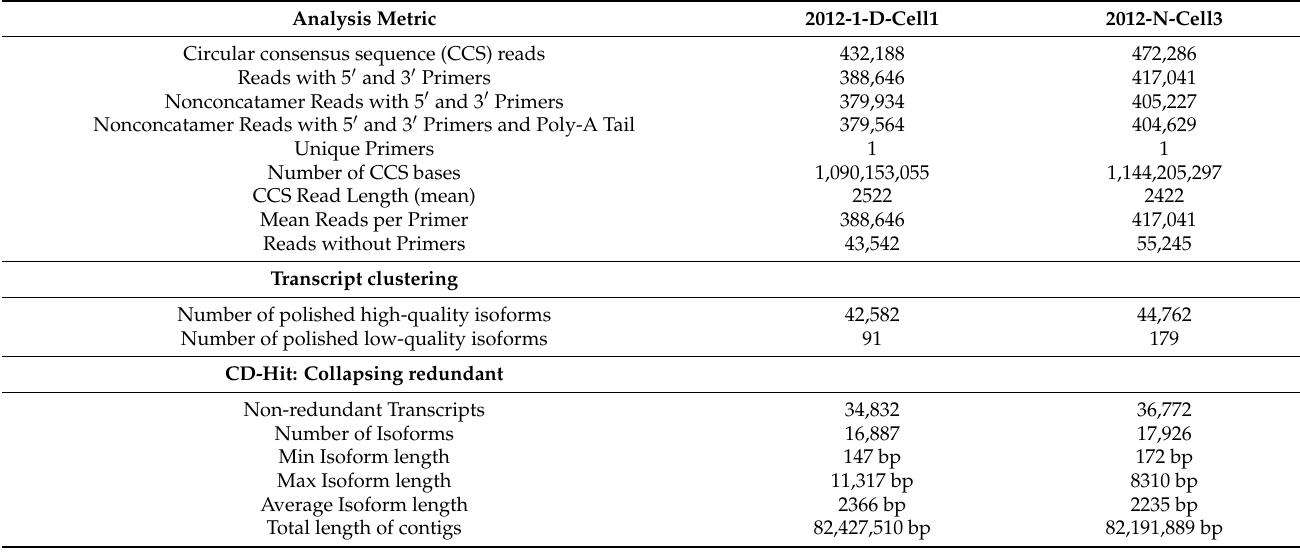
Table 1. Pacbio summary statistics in dwarf and normal